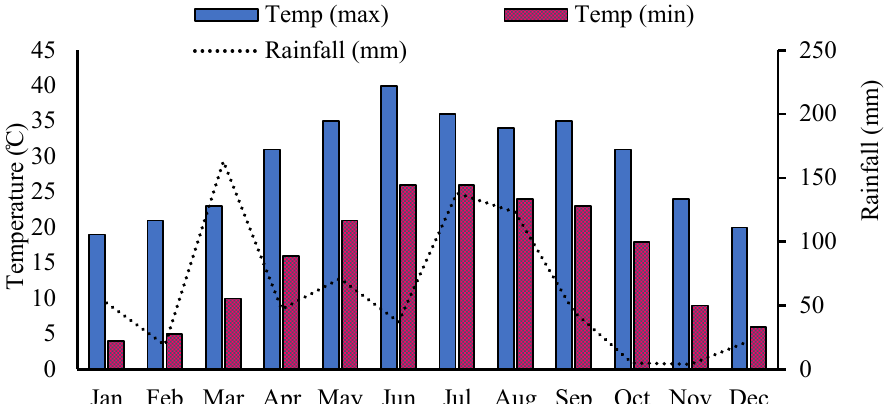
Figure 1. Total monthly rainfall (mm) and minimum and maximum temperature ( ◦ C) of the experi- mental area from January to December 2016. Source: Department of Climate Change of Peshawar University head office Khyber Pakhtunkhwa 2010–2016.